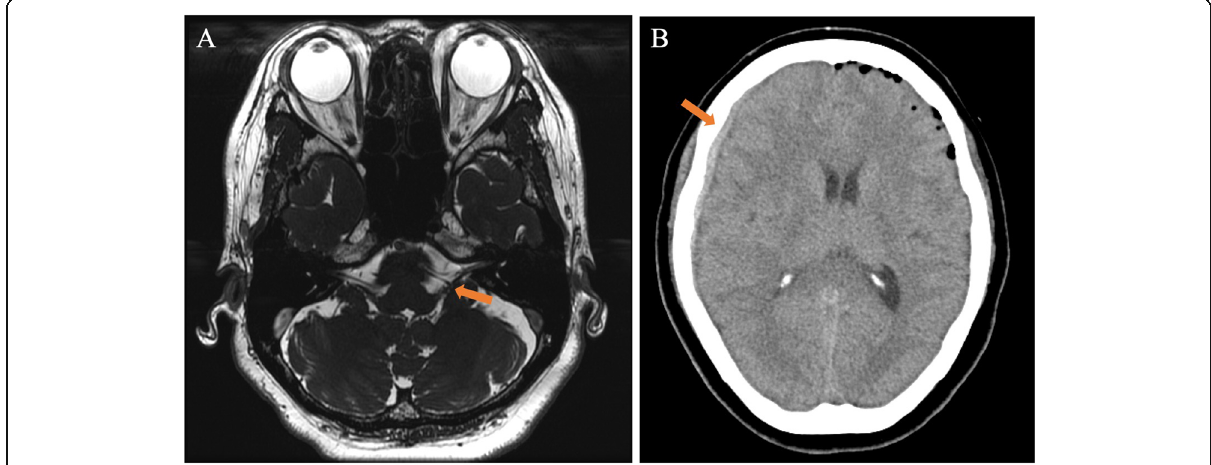
Fig. 1 a Preoperative magnetic resonance images. Arrow indicates the posterior inferior cerebellar artery adjacent to the zone of exit of the root of facial nerve. b Postoperative computed tomography scans showing unilateral supratentorial subdural hematomas